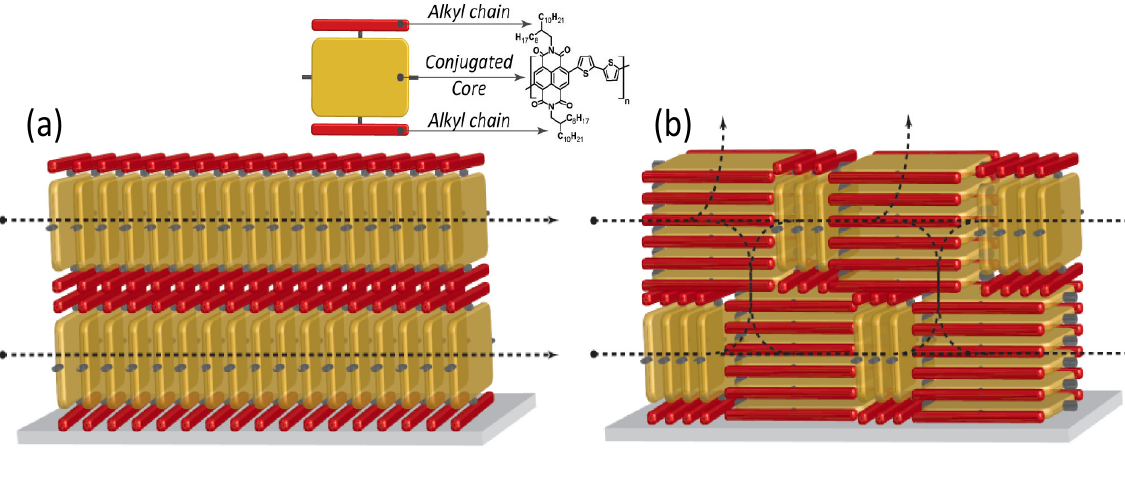
Figure 6. Graphical depiction showing the charge carrier paths available in ( a ) an edge-on; and in ( b ) a mixed edge-on/face-on ordered thin-film (tilted phases are missing in this scheme for simplicity). In the inset, the reading key is reported by using again the example of